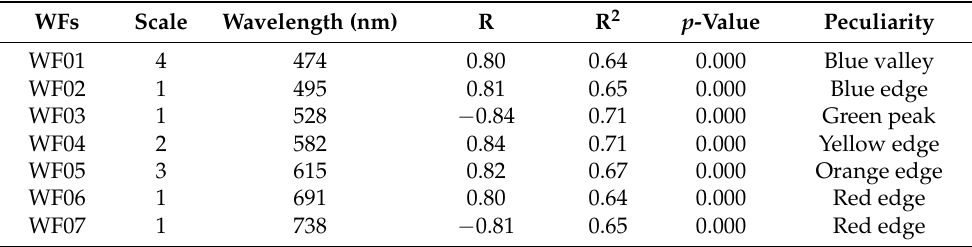
Table 2. Wavelength positions and scales of identified wavelet